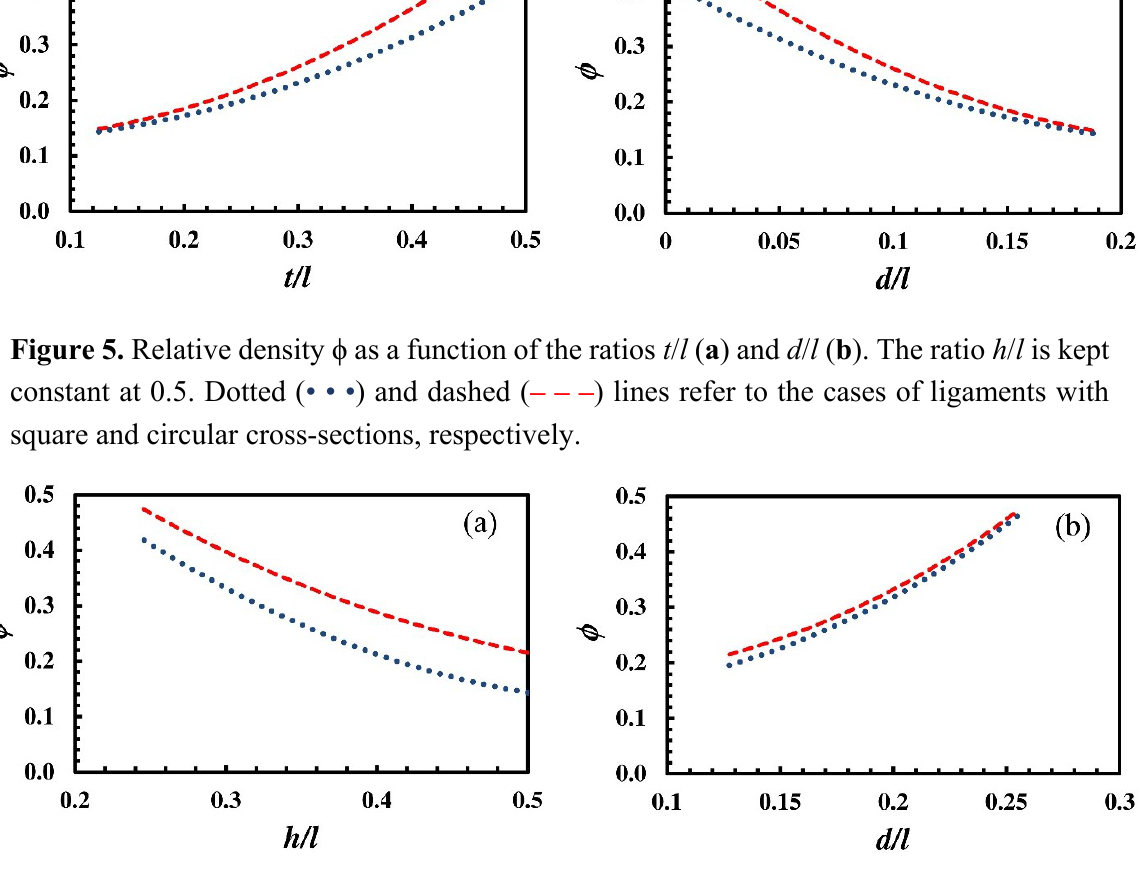
Figure 6. Relative density ϕ as a function of the ratios h / l ( a ) and d / l ( b ). The ratio t / l is kept constant at 0.245. Dotted (• • •) and dashed ( ‒ ‒ ‒ ) lines refer to the cases of ligaments with square and circular cross-sections,